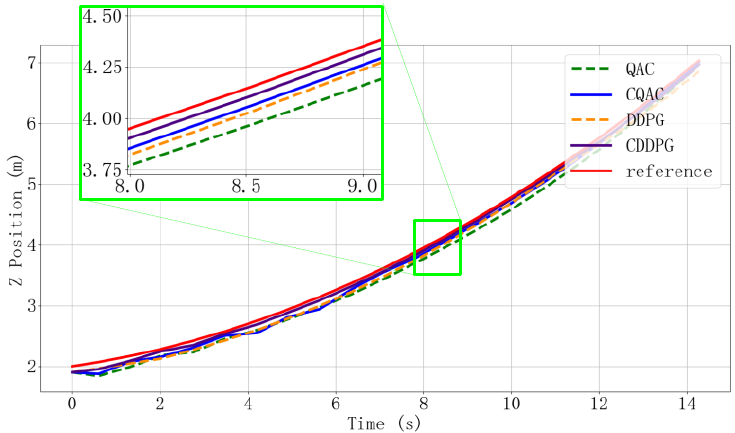
Figure 18. Position trajectory in the Z-axis direction under uniform acceleration.